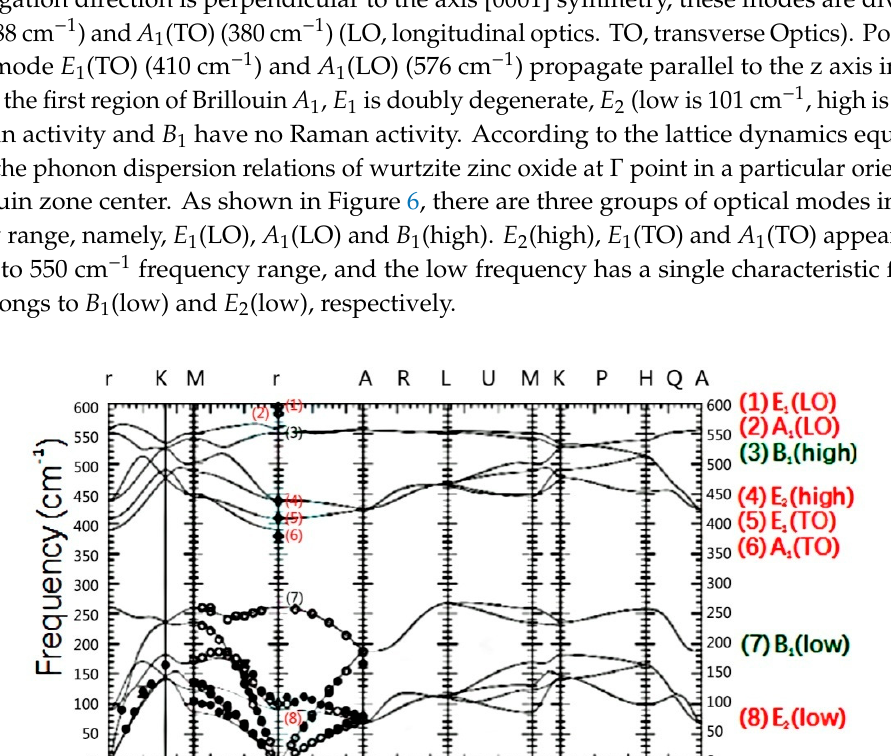
Figure 6. phonon dispersion relationship of wurtzite zinc oxide are calculatedat Γ point in the specified direction of the Brillouin zonecenter by using the lattice dynamics equation. Molecular vibration